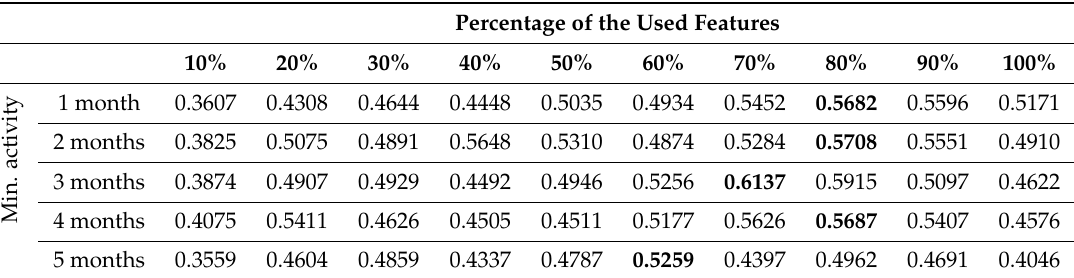
Table A19. F-score macro average for the SVM classification of three levels of the hierarchy in the Enron dataset. The values which are bolded are the best results for a given minimum communication